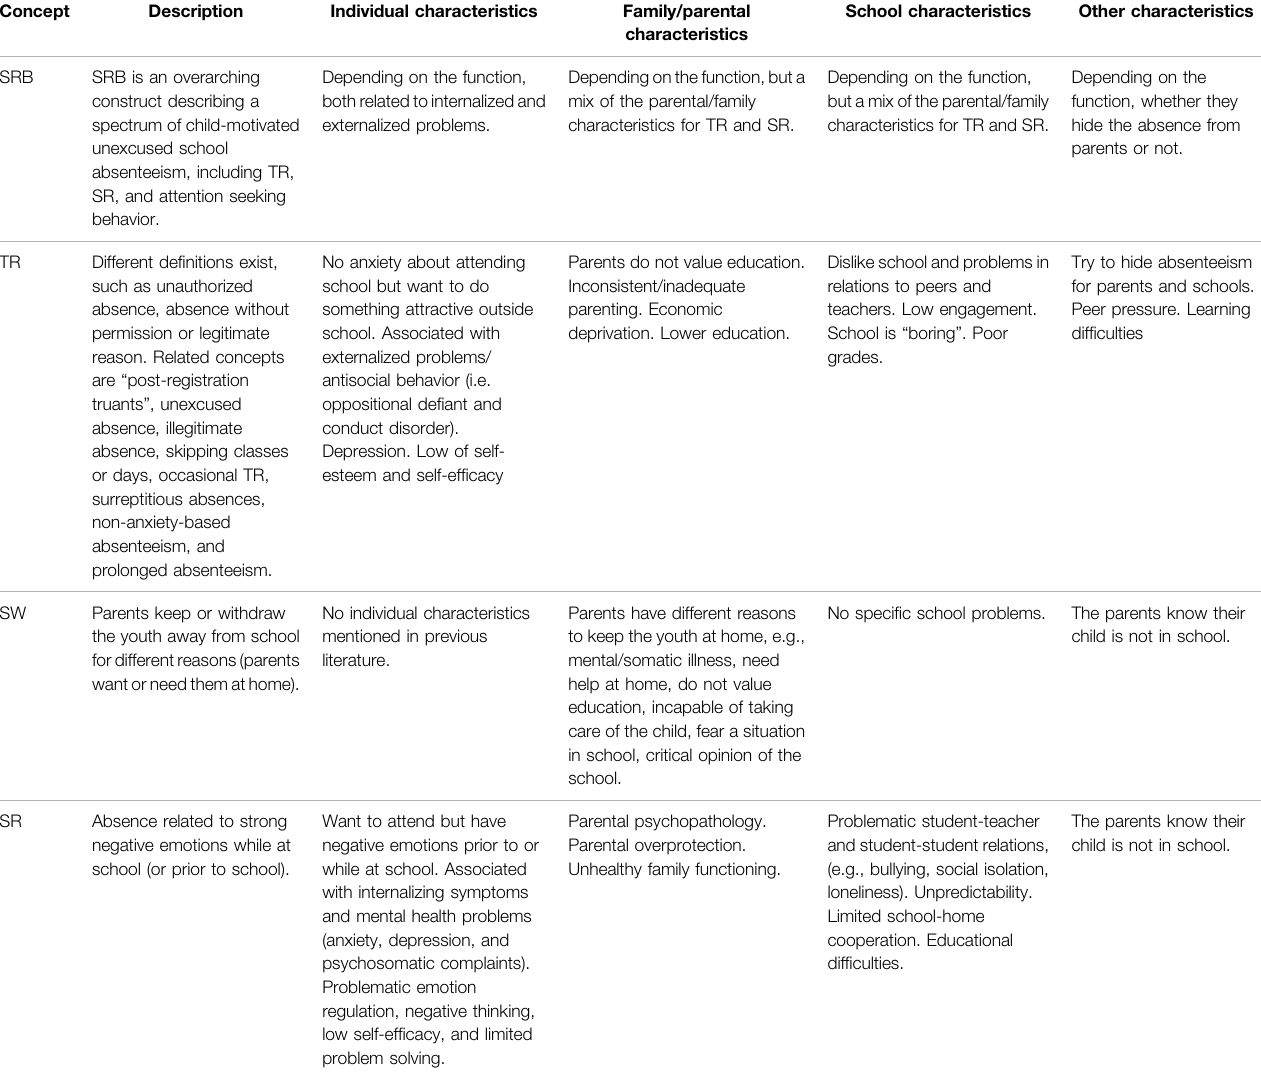
TABLE 1 | Concepts and characteristics of